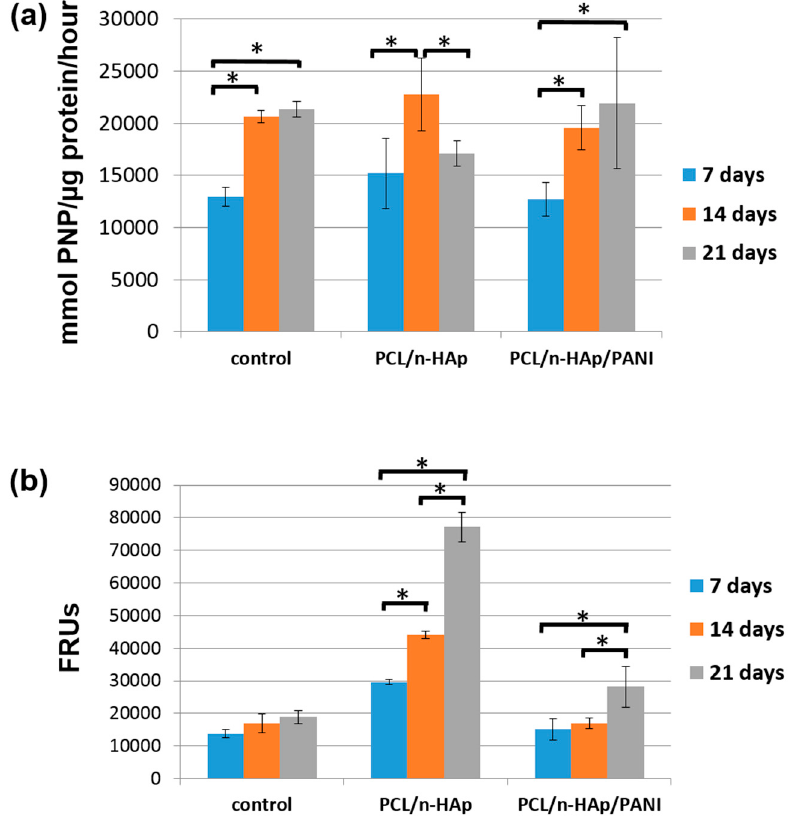
Figure 9. ( a ) Alkaline phosphatase activity test; ( b ) Mineralization progress measured by concentra- tion of hydroxyapatites of NHOst cell culture on obtained materials. *: the results are statistically significant.